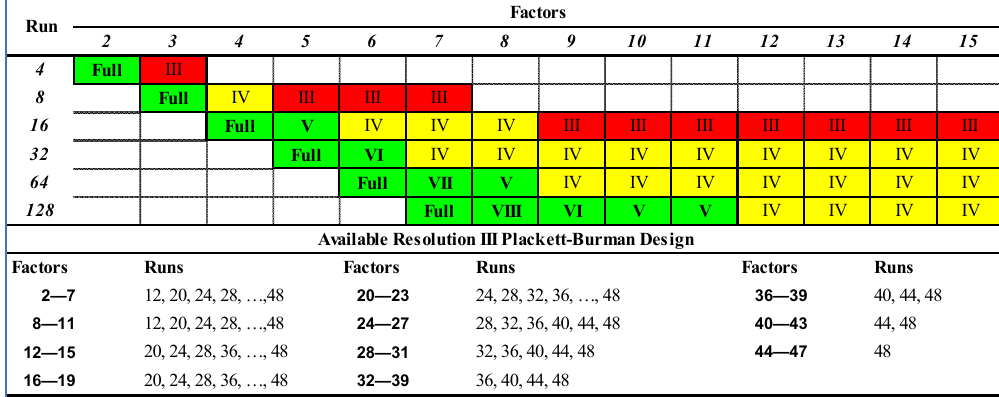
Figure 5. Software scheme to help select appropriate designs.